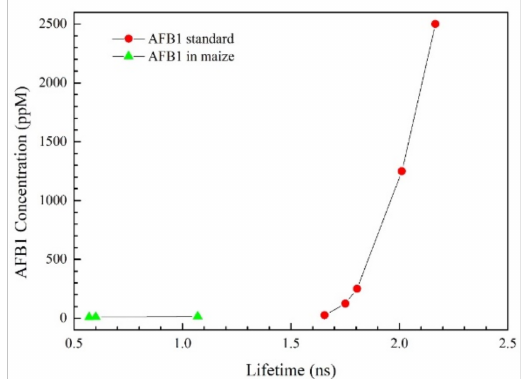
Figure 4. Standard reagent AFB1 concentration by fluorescence lifetime.